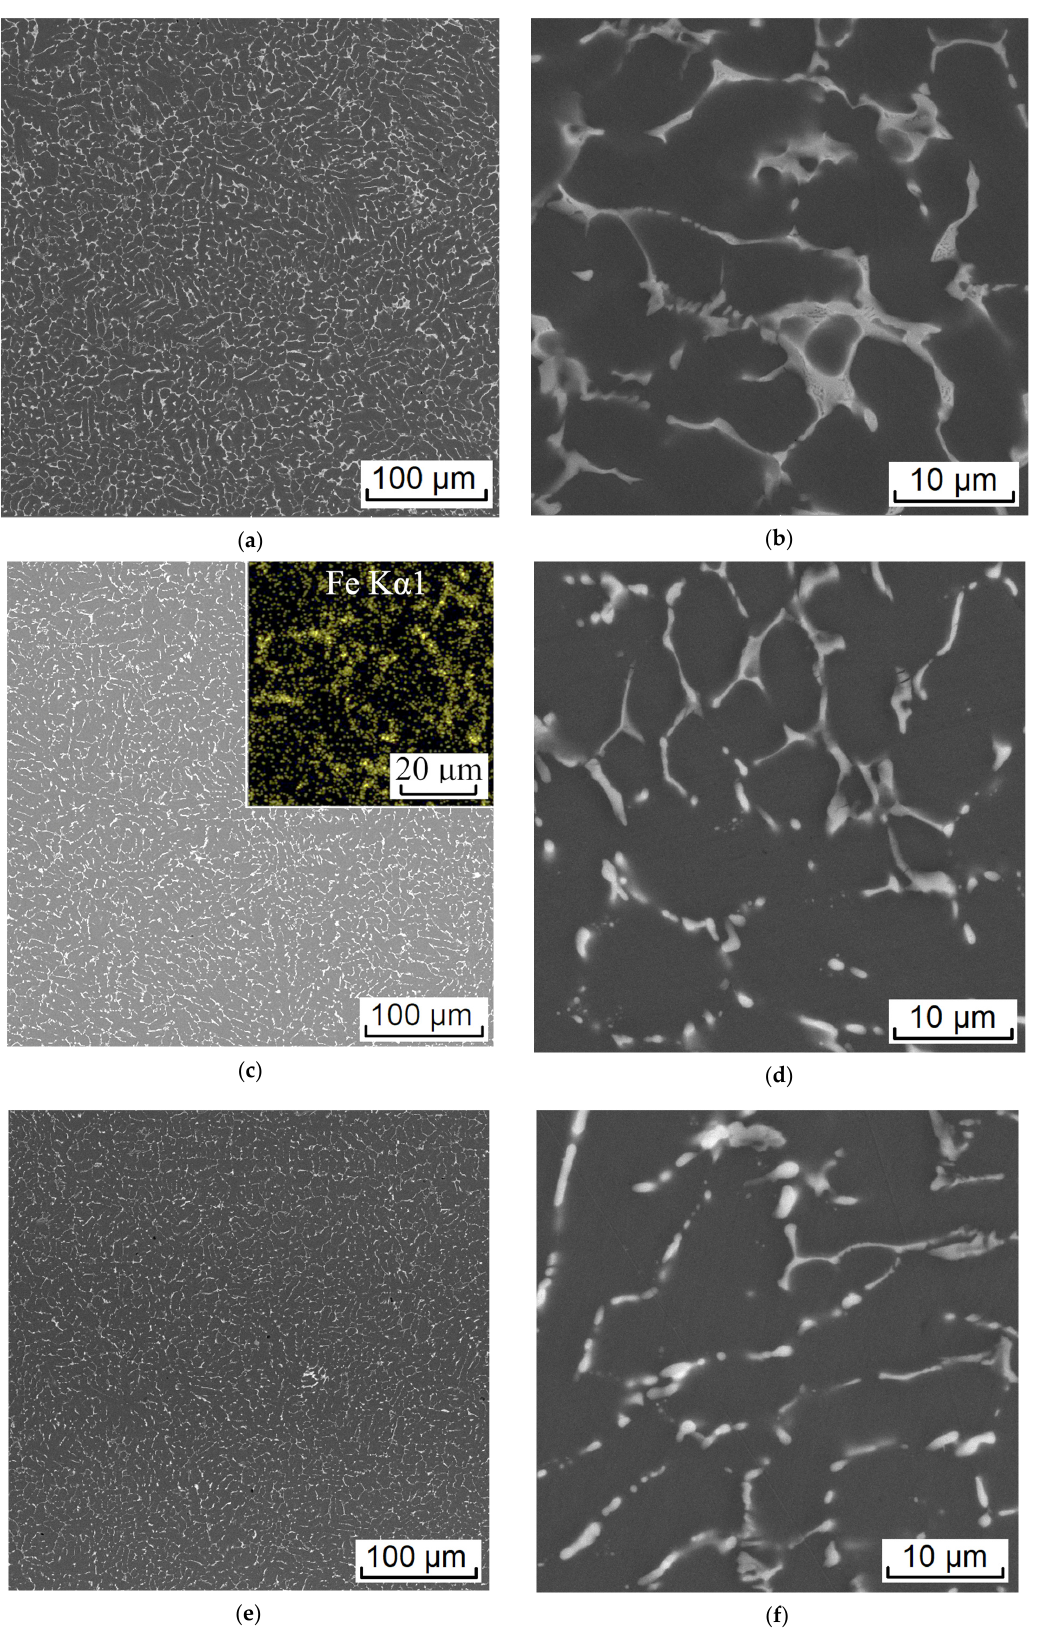
Figure 8. Microstructure (SEM) of the experimental alloy ZCF in the as ‐ cast state ( a , b ) and after annealing at 450 °C ( c , d ) and 500 °C ( e , f ). annealing at 450 ◦ C ( c , d ) and 500 ◦ C ( e , f